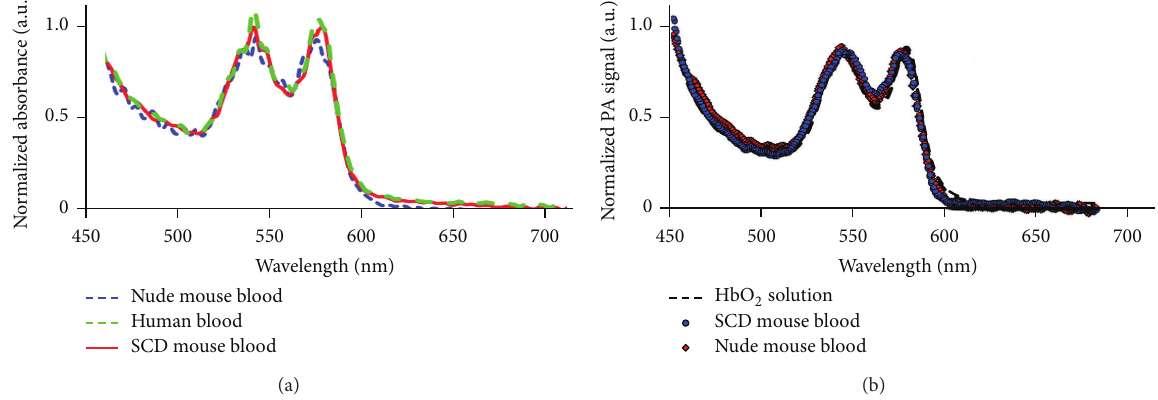
Figure 3: Absorption and PA spectra of HbS and HbA alone and in RBCs. (a) Conventional absorption spectroscopy of nude mouse blood, SCD mouse blood, and human blood. Sample absorption was normalized to absorption at 450 nm. (b) Single cell PA spectroscopy using spectrally tunable automatic laser optical parametric oscillator (OPO). The spectrum of HbO 2 was acquired using conventional spectroscopy from 90% oxygenated hemoglobin